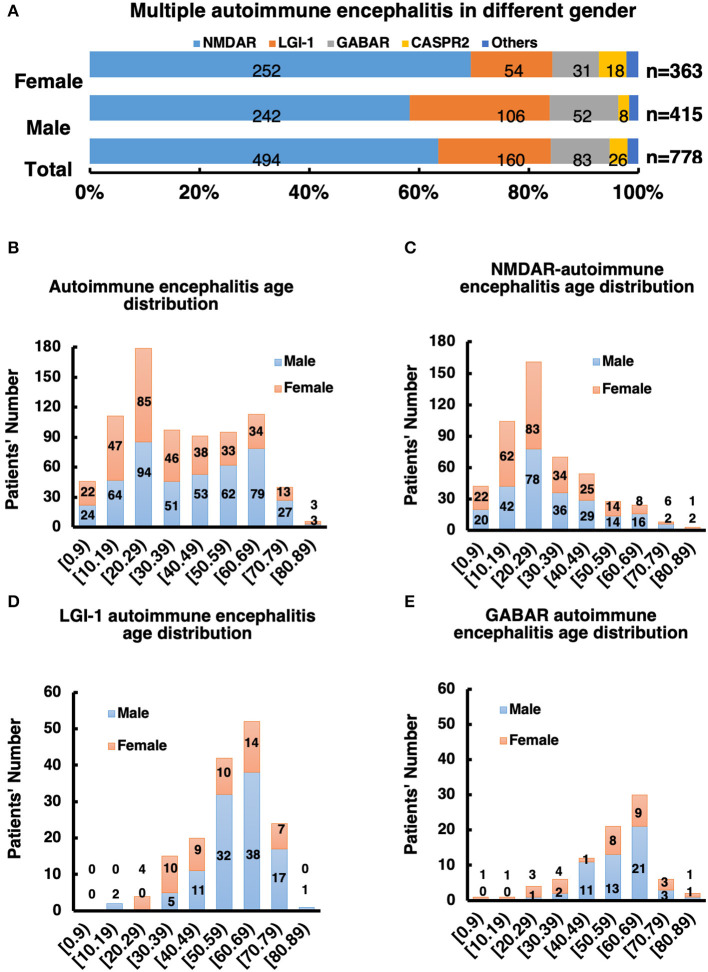
(A) Male to female ratio of all subtype AE patients. (B–E) Distribution of gender and age of AE patients and its subtype.